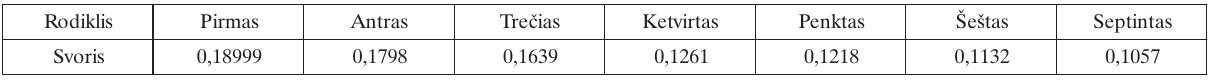
Table 3. Weights of particular criteria used to assess the effectiveness of marketing strategies